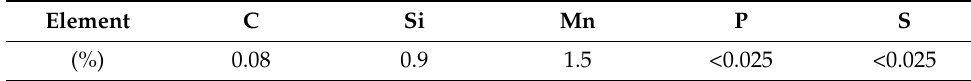
Table 4. Chemical composition of VAC 60 [7].